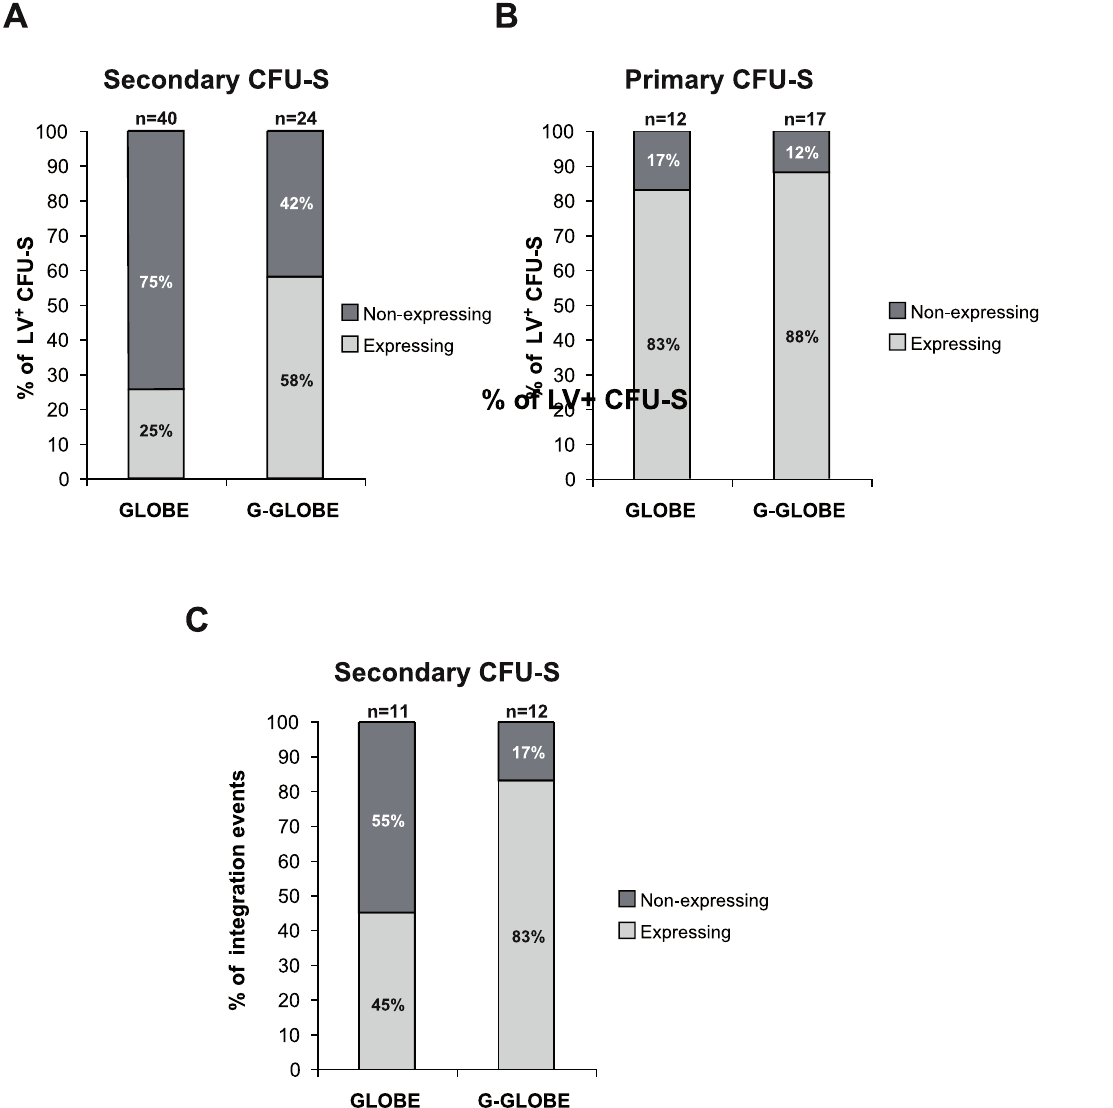
Figure 5. Long-term human b -globin expression in the erythroid progeny of G-GLOBE-transduced HSCs. (A) Single erythroid CFU-S were collected from the spleens of secondary recipients 12 days after transplantation with GLOBE- and G-GLOBE-containing BM cells (16 mice per group). Donor cells are derived from 4 different primary recipients for each vector. LV-containing clones (40 and 24 for GLOBE and G-GLOBE, respectively) carrying single integrants, were analyzed by FACS for b -globin expression. The percentages of b -globin + (light grey) and b -globin 2 (dark grey) LV- containing CFU-S are represented. Transgene expression was observed only in 25% of GLOBE-containing CFU-S, whereas the presence of GATA1 -HS2 element into the LTRs was able to sustain human b -globin expression in 58% of G-GLOBE-transduced CFU-S. The difference in the proportion of transgene expressing CFU-S between the two groups was statistically significant ( P , 0.005; Fisher exact test). (B) Single erythroid CFU-S were collected from the spleens of mice 12 days after transplantation with GLOBE- and G-GLOBE-transduced BM cells (4 and 7 recipients, respectively. LV-containing clones, carrying on average 1.6 GLOBE and 1.4 G-GLOBE integrants, respectively, were analyzed by FACS for human b -globin expression. Transgene expression wasobserved in 83%and88%of CFU-S transduced with GLOBE andG-GLOBE LV (n=12 andn=17 forGLOBE andG-GLOBE,respectively). No statistical difference in the proportion of globin expressing CFU-S between the two groups was observed ( P . 0.1; Fisher exact test). (C) GLOBE and G- GLOBE integration sites in secondary CFU-S were cloned by LM-PCR and mapped on the mouse genome. CFU-S harboring individual integration events were analyzed for b -globin gene expression (n=11 and n=12 for GLOBE and G-GLOBE, respectively). A 2-fold increase in the proportion of b -globin + CFU-S carrying the G-GLOBE vector was observed compared to the percentage of GLOBE-transduced b -globin expressing